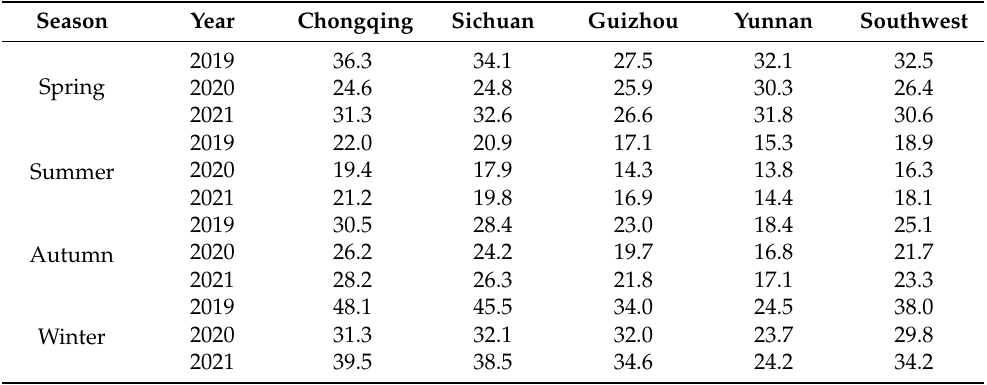
Table 4. Quarterly variation of PM 2.5 concentration in provinces and cities in southwest China (Unit: µ g/m 3